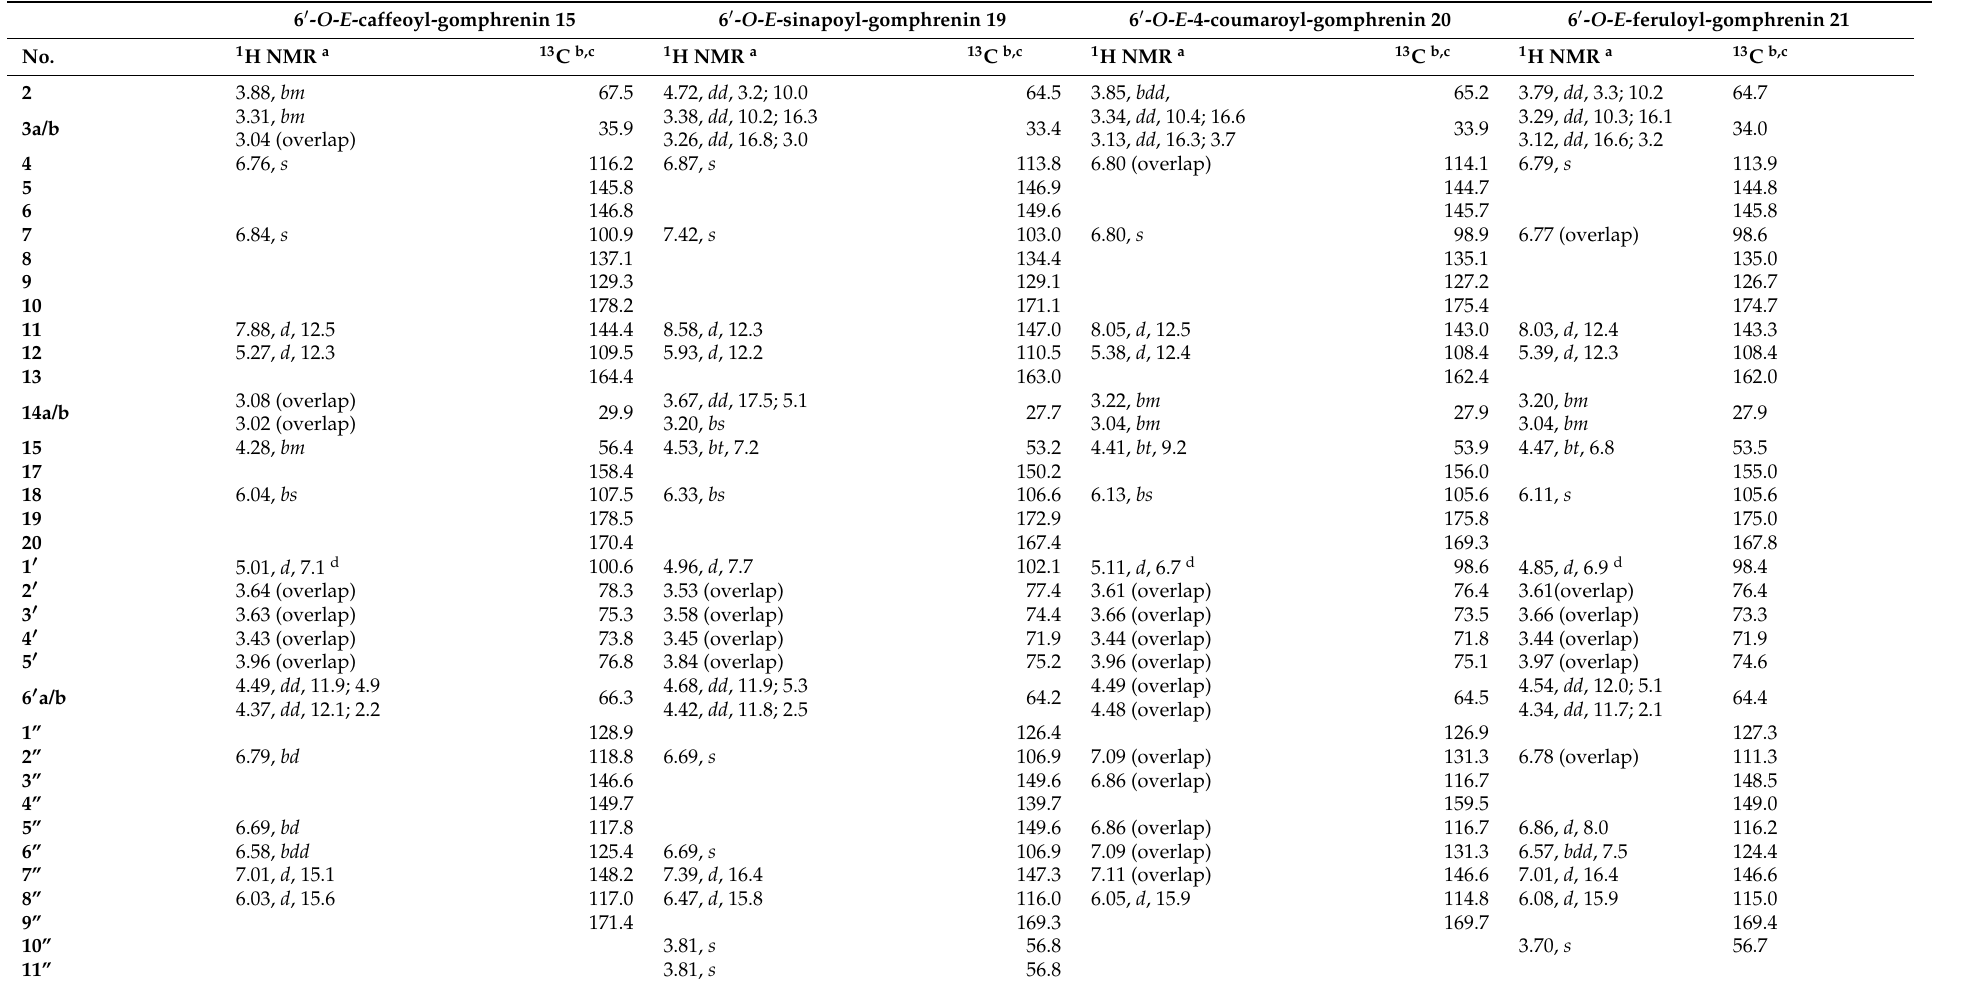
Table 4. The NMR data obtained in D 2 O ( 15 , 20 and 21 ) and CD 3 OD/d-TFA ( 19 ) for the principal acylated betacyanins isolated from Basella alba L. fruits. The 1 H and 13 C spectra of the pigments are presented in Figures